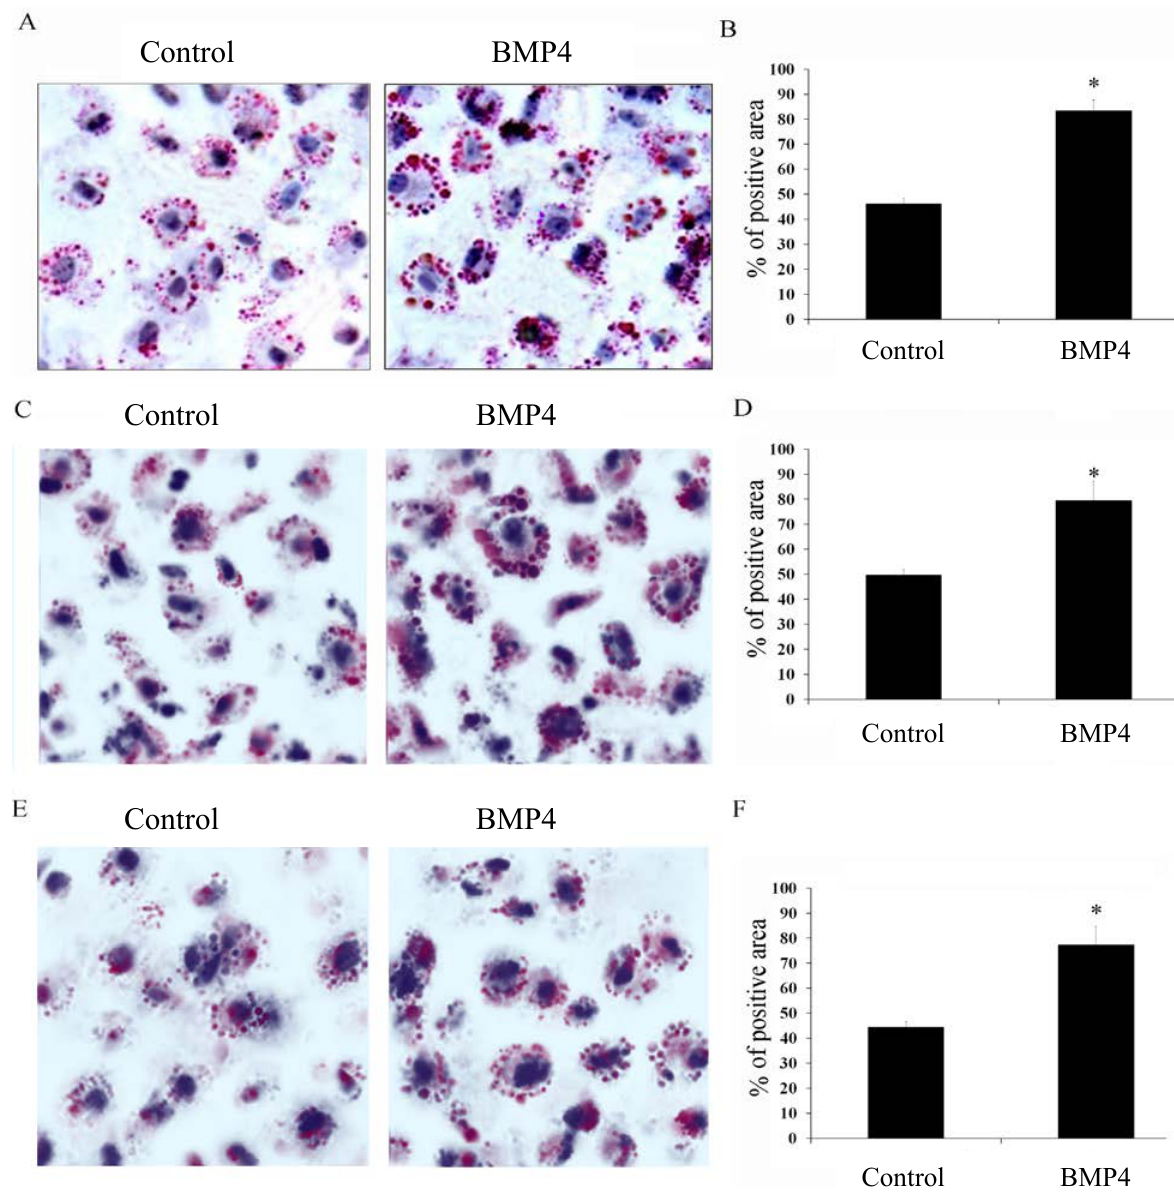
Figure 1. Effect of BMP4 on macrophage foam cell formation. After pretreating with PBS (control) or BMP4 for 48 h, cells were stained with Oil Red O. 400× photomicrographs and the quantitative analysis of the RAW 246.7 cells ( A ) and ( B ), MPM ( C ) and ( D ) and PBMCs ( E ) and ( F ) were demonstrated equivalent macrophage area density but higher percent of Oil Red O positive area compared with controls. * p <